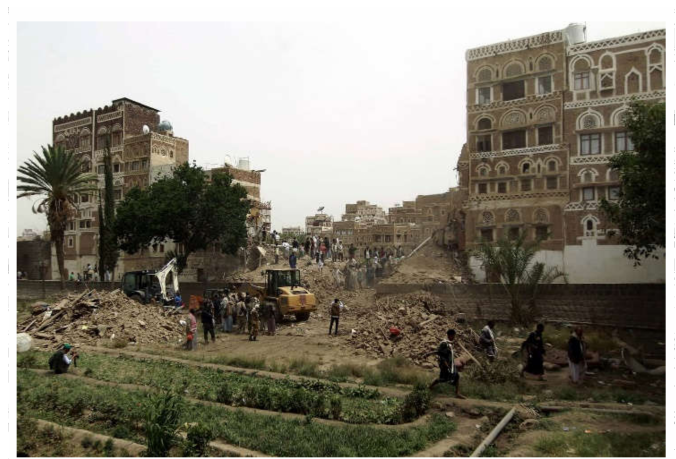
Figure 4. Buildings of in the Old City of Sana’a in the aftermath of the air strike of June 2015. Photograph: Mohammed Huwais/AFP/Getty